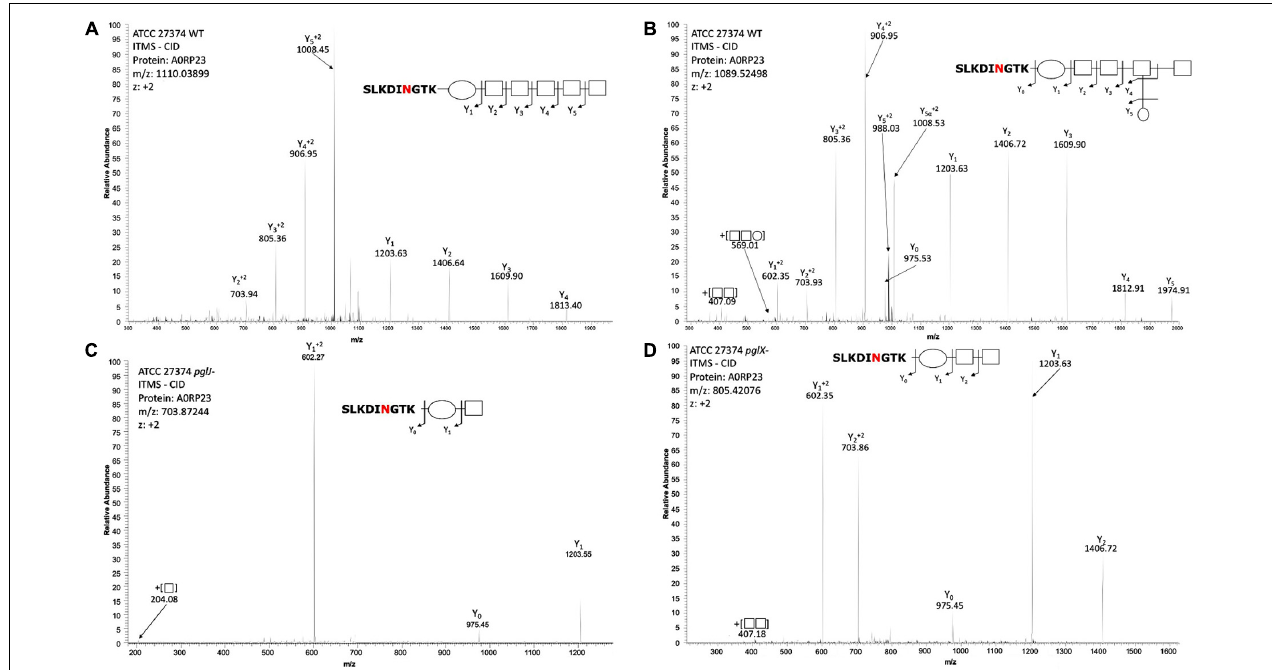
FIGURE 4 | Mass-spectrometric analysis of Cff WT, pglJ-, and pglX- glycopeptides. Fragmentation of characteristic ions obtained by precursor ion scanning of digested Cff lysate samples using liquid chromatography-mass spectrometry. Red lettering indicates possible glycosylation site. Spectra of WT Cff have two glycans: (A) HexNAc 5 -diNAcBac and (B) HexNAc-[Hex]-HexNAc 3 -diNAcBac. (C) The peptide from the pglJ- mutant only shows the presence of a mass consistent with HexNAc-diNAcBac. (D) The peptide from the pglX- mutant indicates that it is modified with